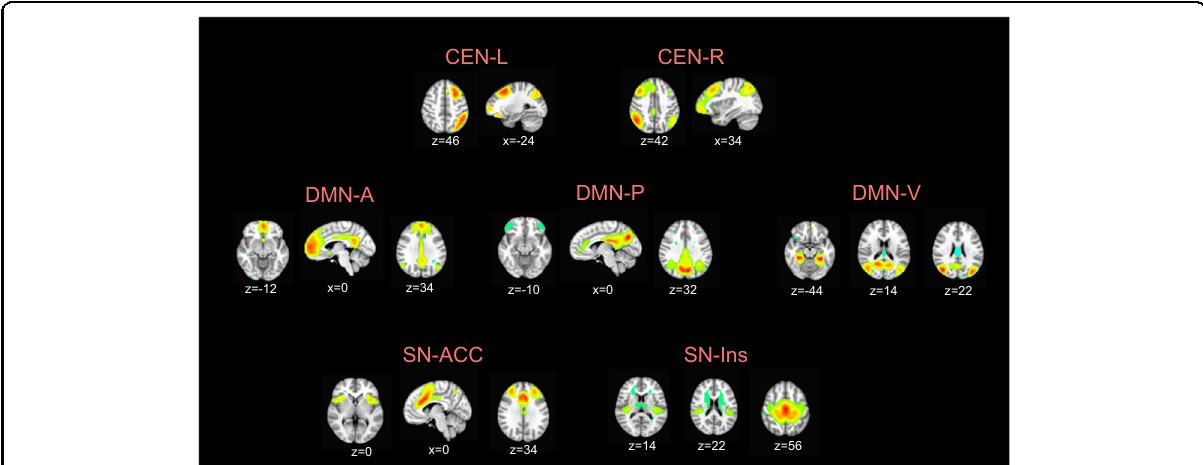
Fig. 1 Intrinsic networks derived from group ICA. Maps were thresholded at t 68 > 3.93 ( α = 0.0001). All views and coordinates are presented in radiological convention. CEN includes dorsolateral prefrontal cortex, middle frontal gyrus, and inferior parietal lobule, DMN-A includes anterior medial prefrontal cortex, subgenual anterior cingulate cortex, and cingulate gyrus, DMN-P includes posterior cingulate cortex, precuneus, and inferior parietal lobule, DMN-V includes middle temporal lobe, hippocampus/parahippocampal region, and posterior cingulate cortex, SN-ACC includes dorsal anterior cingulate cortex and anterior insula, SN-Ins includes mid- and posterior insula, striatum, and somatosensory cortex; CEN-L = left central executive network; CEN-R = right central executive network; DMN-A = anterior default mode network; DMN-P = posterior default mode network; DMN-V = ventral default mode network; SN-ACC = dorsal anterior cingulate cortex-based salience network; SN-Ins = insula-based salience